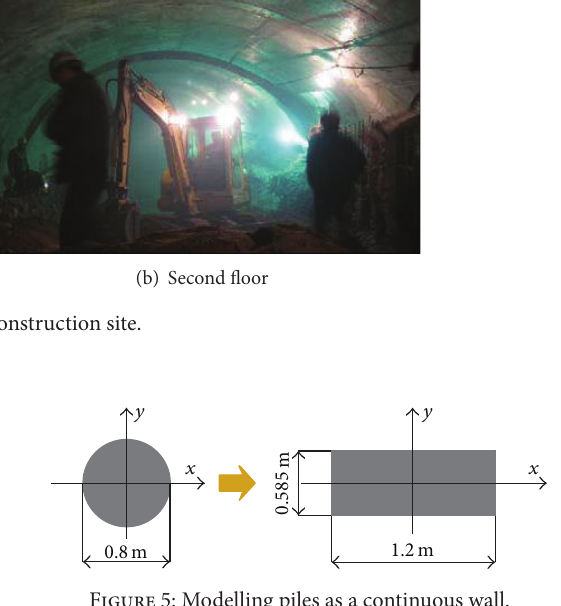
Figure 5: Modelling piles as a continuous